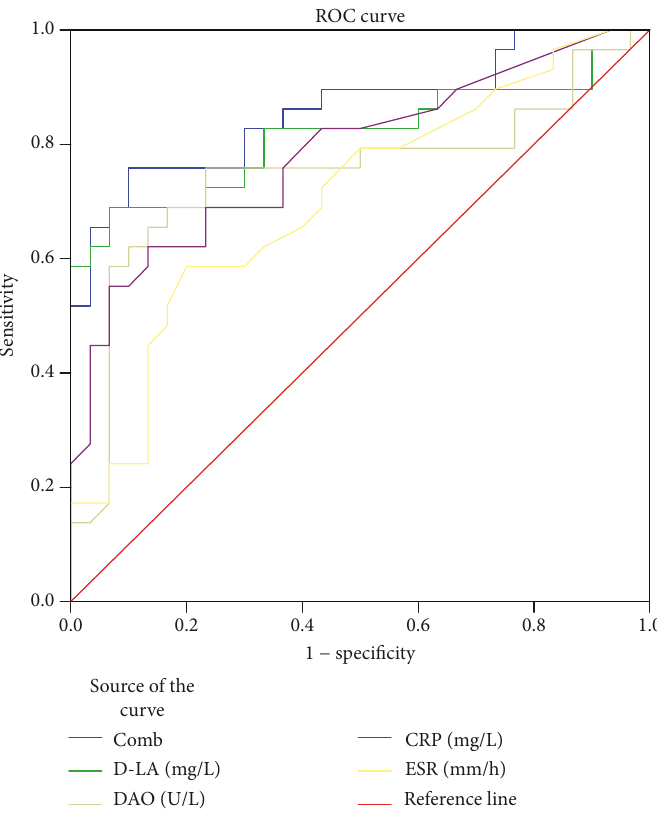
Figure 2: Receiver operating characteristic curves of the various biomarkers in CD active compared to CD remission.